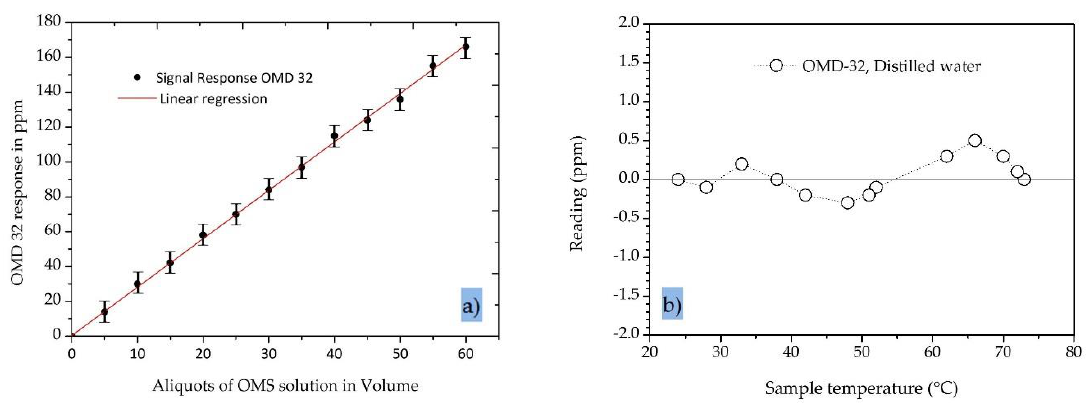
Figure 6. Properties of the OMD-32 online oil-in-water sensor. ( a ) The signal response of the sensor when tested with an oily model solution (OMS). ( b ) The temperature dependence of the sensor in distilled water.